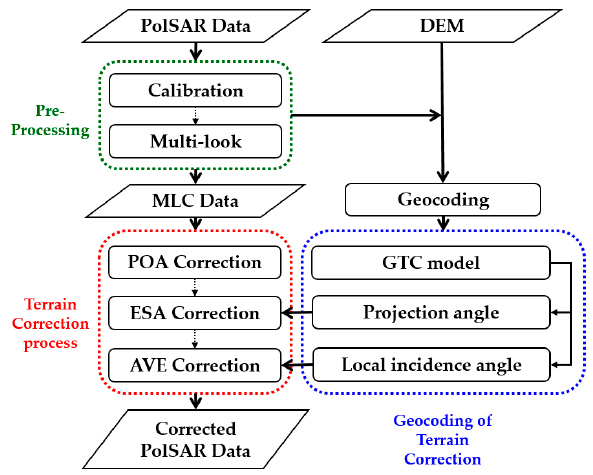
Figure 1. Flow chart of the proposed method.